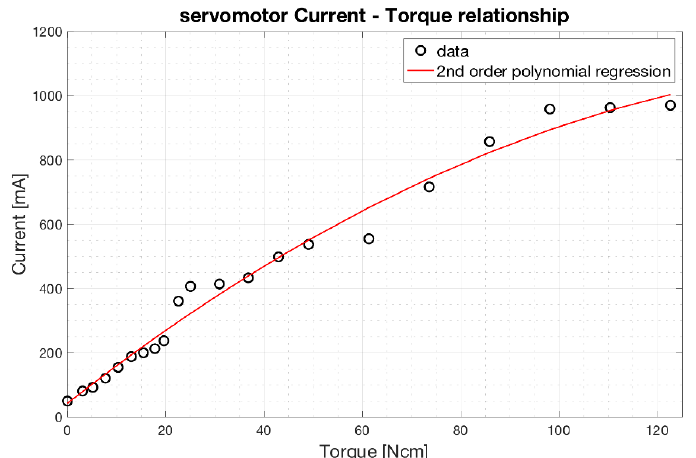
Figure 12. Relationship between the current absorbed by the servomotor (scaled in mA) and the torque generated (scaled in Ncm). The 2nd order polynomial regression function is depicted as red continuous line.